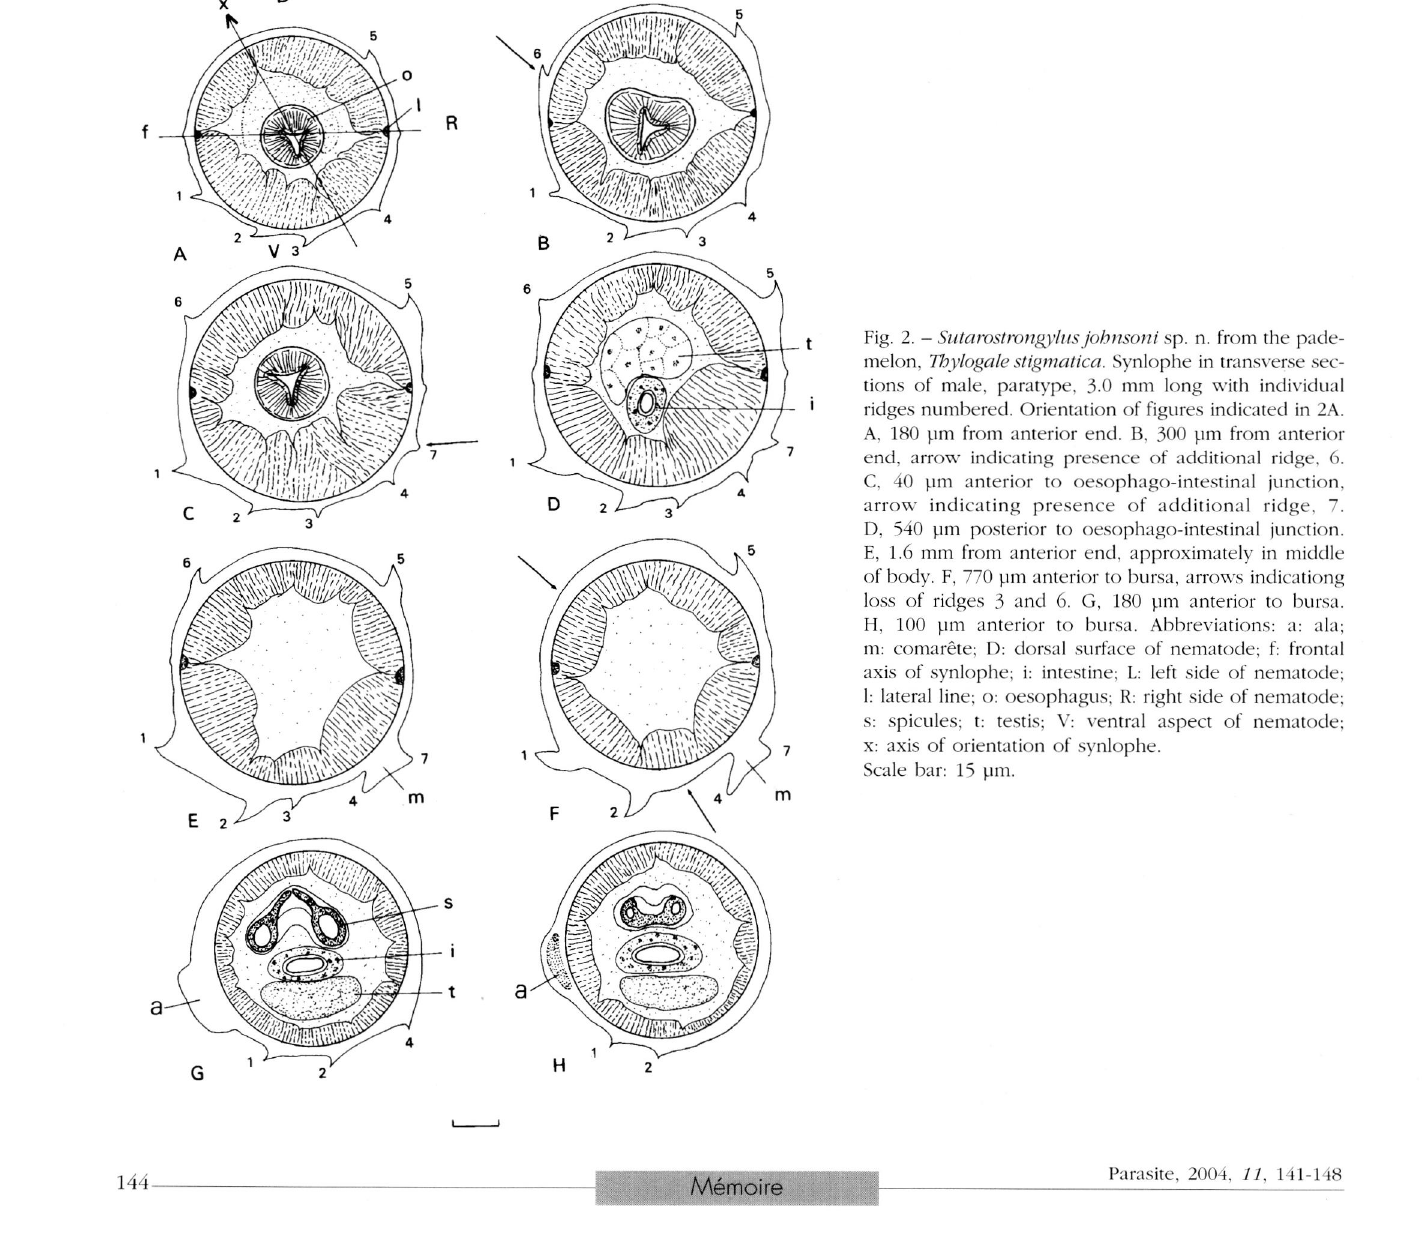
Fig. 2. - Sutarostrongylus johnsoni sp. n. from the pade­ melon, Thylogale stigmatica. Synlophe in transverse sec­ tions of male, paratype, 3.0 mm long with individual ridges numbered. Orientation of figures indicated in 2A. A, 180 pm from anterior end. B. 300 pm from anterior end. arrow indicating presence of additional ridge, 6. C, 40 μ m anterior to oesophago-intestinal junction, arrow indicating presence of additional